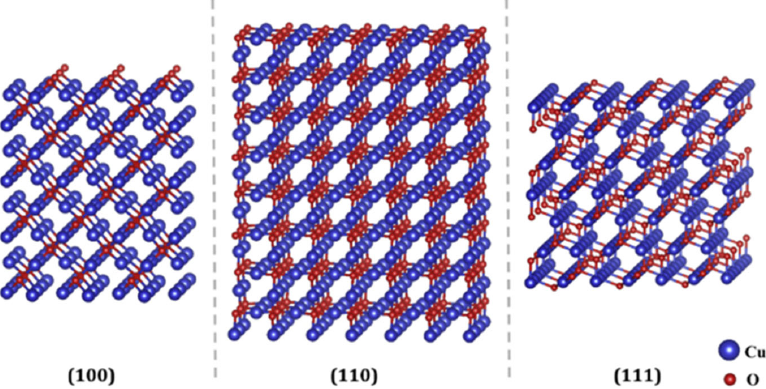
Figure 2. Side view scheme of the selected (100), (110), and (111) slabs of a copper(II) oxide (CuO) cube. Adapted with permission from Reference [8]. Copyright 2021 Elsevier.